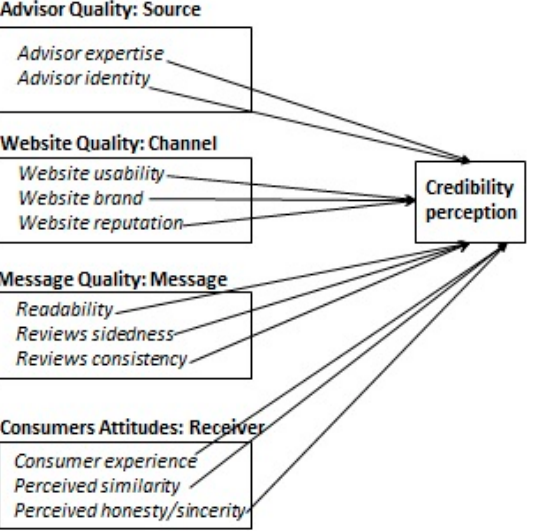
Figure 1. CONCEPT model. (All relationships illustrated in the figure are positive).